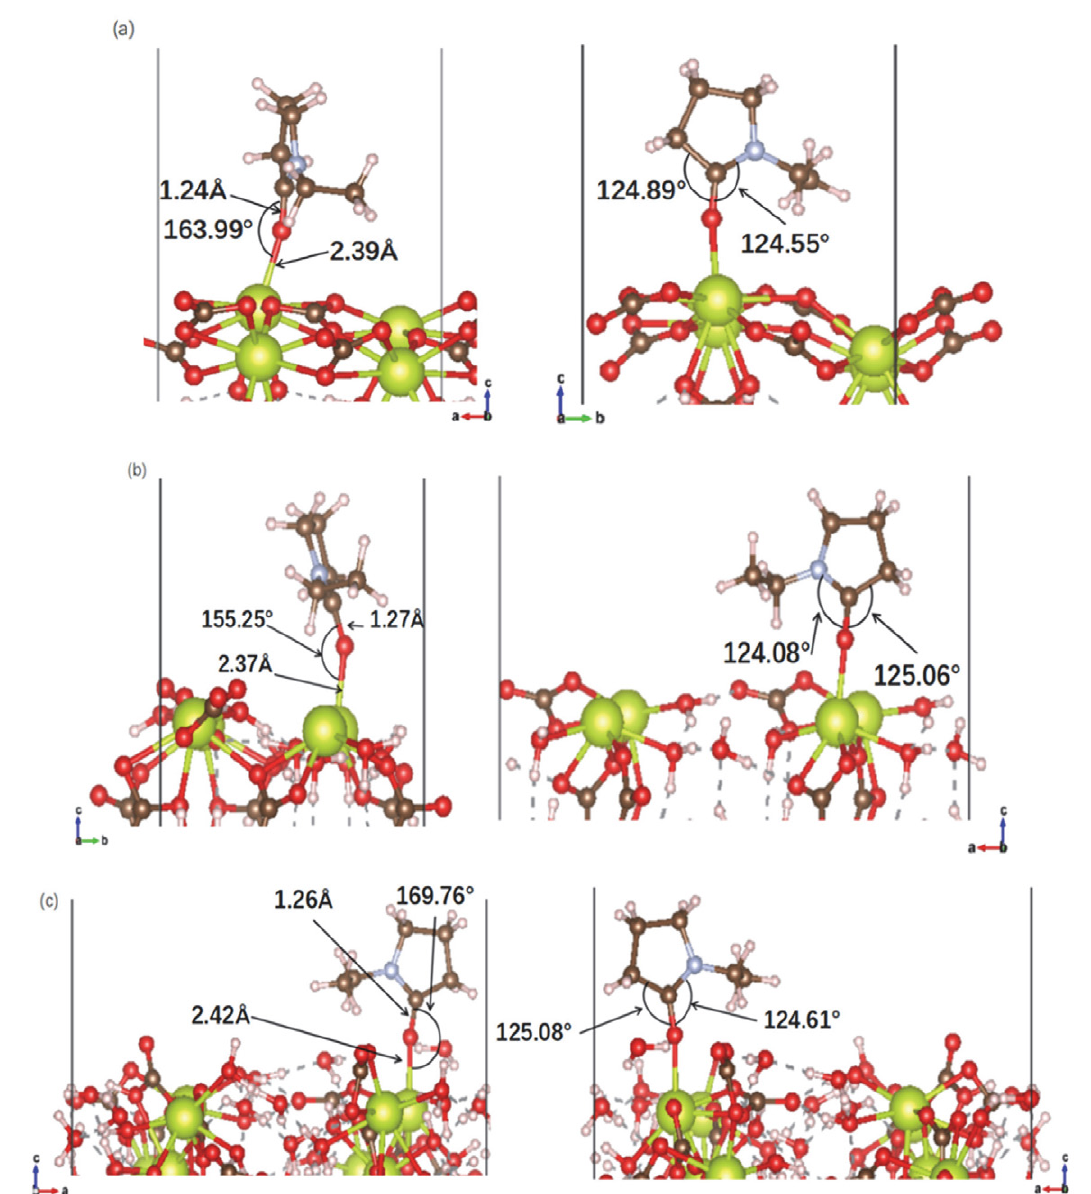
Figure 6. (a) The best adsorption structure of PVP monomer on the surface of stoichiometric cerium carbonate (001), showing two side views in the plane model, (b) the best PVP monomer on the surface of stoichiometric cerium carbonate (010) Adsorption structure, showing two side views in the plane model, (c) the best adsorption structure of PVP monomer on the surface of stoichiometric cerium carbonate (120), showing two side views in the plane